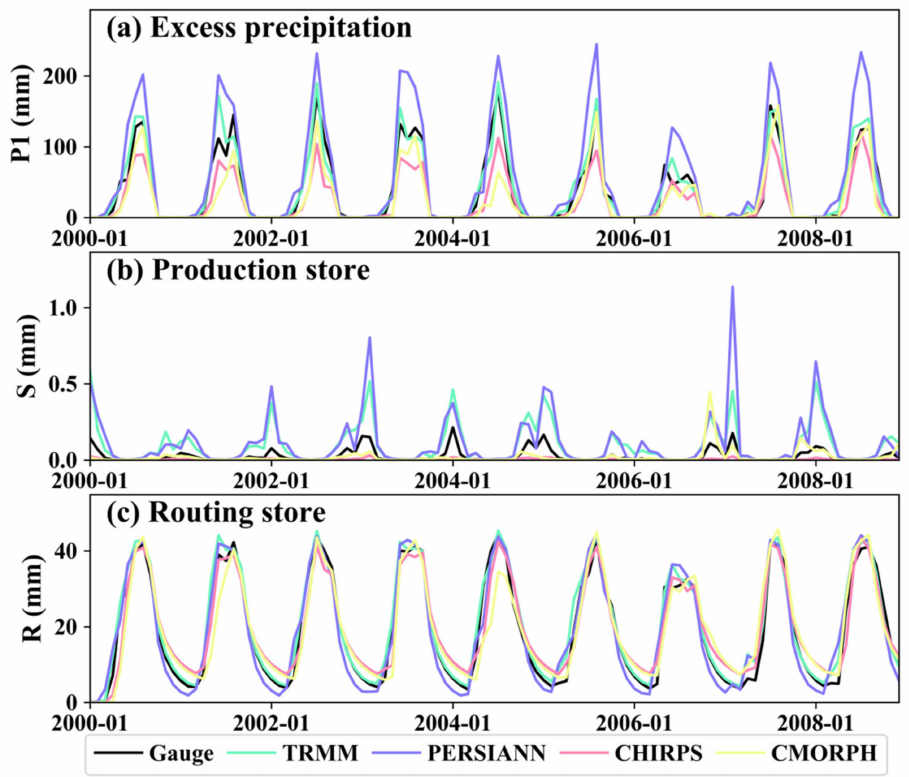
Figure 14. The intermediate process of monthly runoff simulation with gauges and products as inputs during 2000–2008: ( a – c ) are the process of Excess precipitation, Production store, and Routing store, respectively.